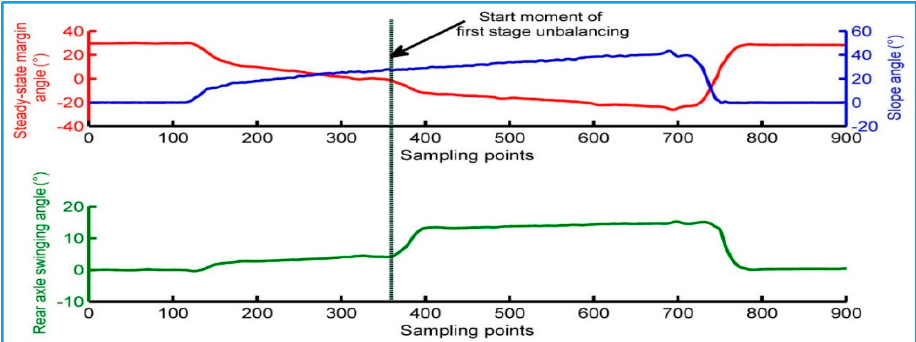
Figure 15. Static rollover stability test data.